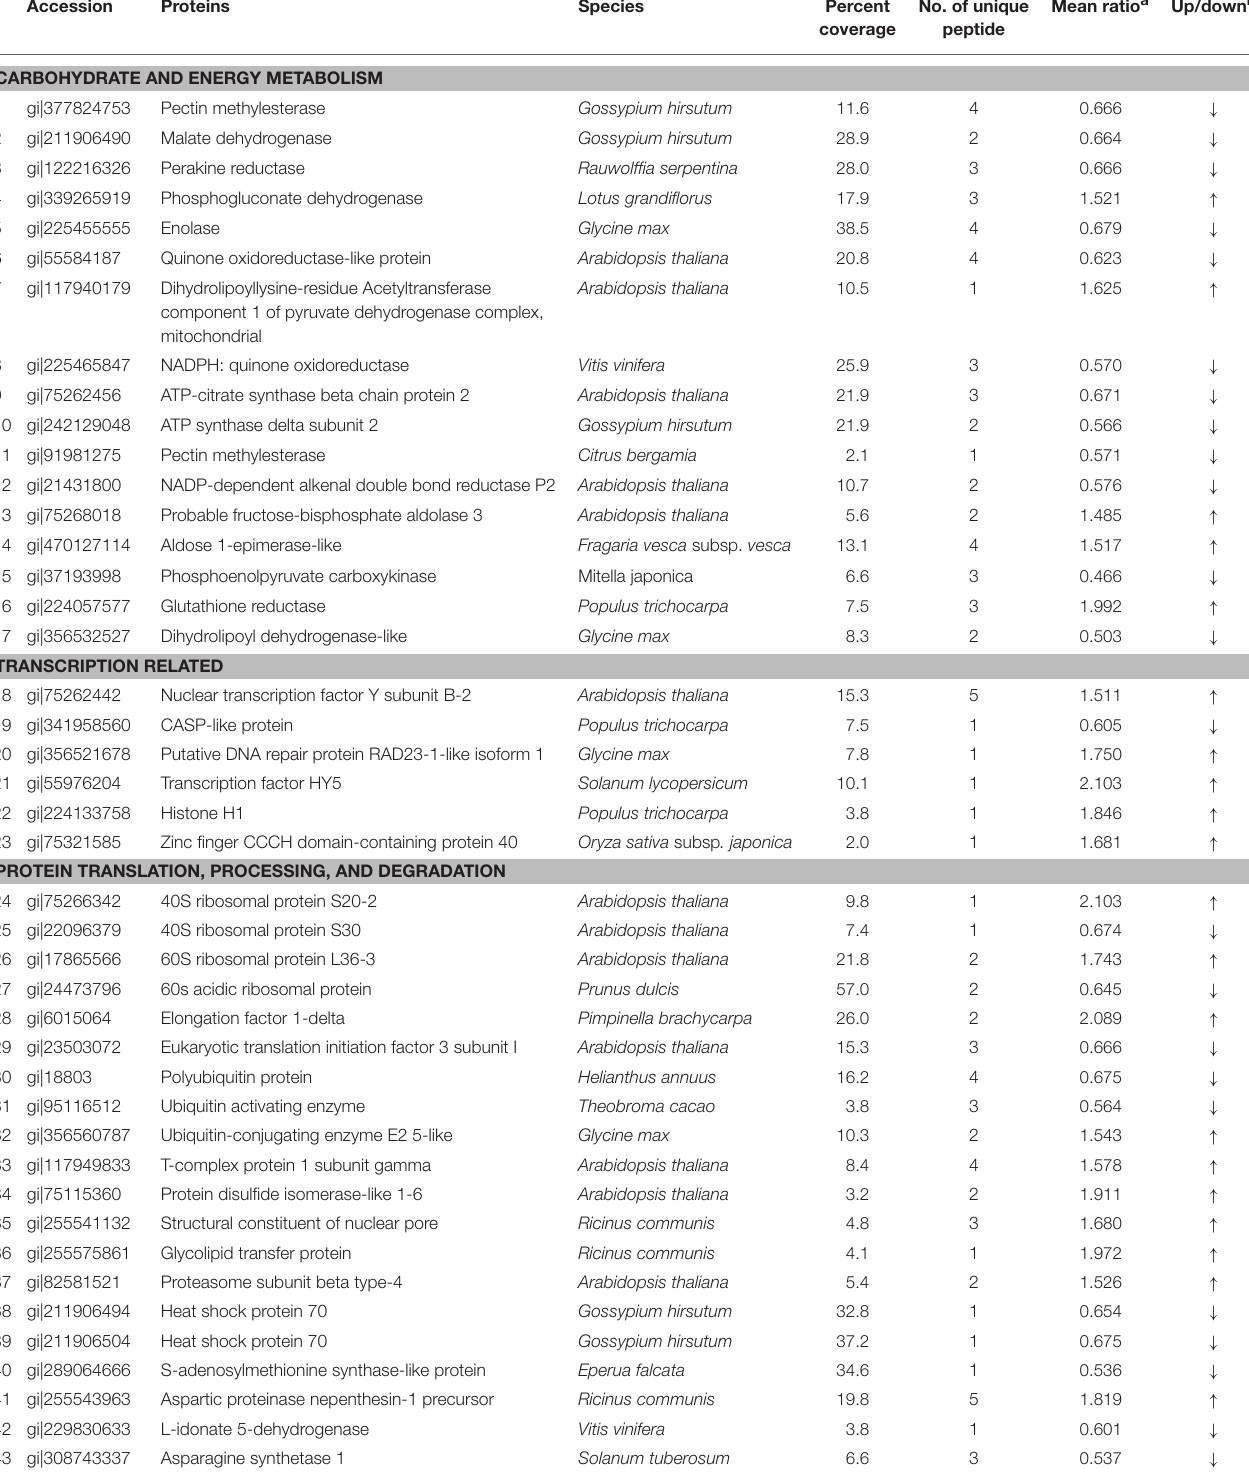
TABLE 1 | Differentially expressed proteins in cotton roots subject to salt stress (200mM